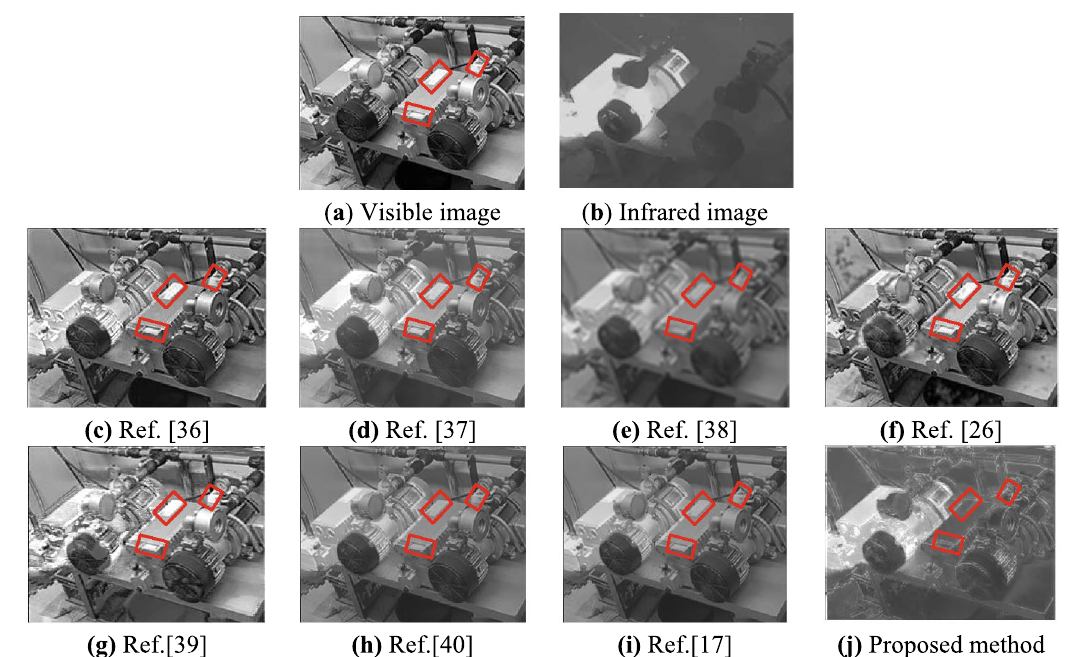
Figure 4. Visible and infrared images (EEFD) and their fusion